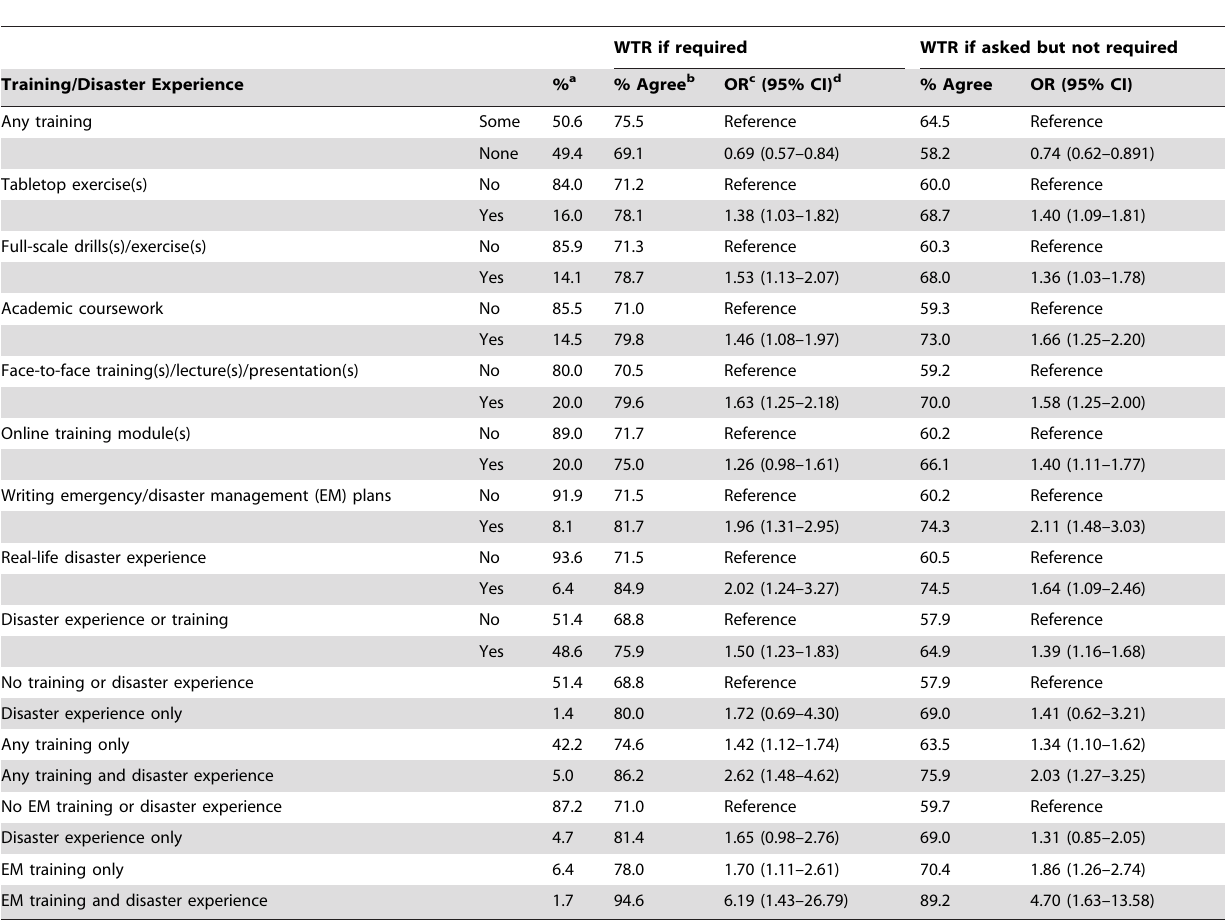
Table 1. Associations between self-reported willingness to respond (WTR) to a radiological dispersal device emergency and respondents’ training and disaster